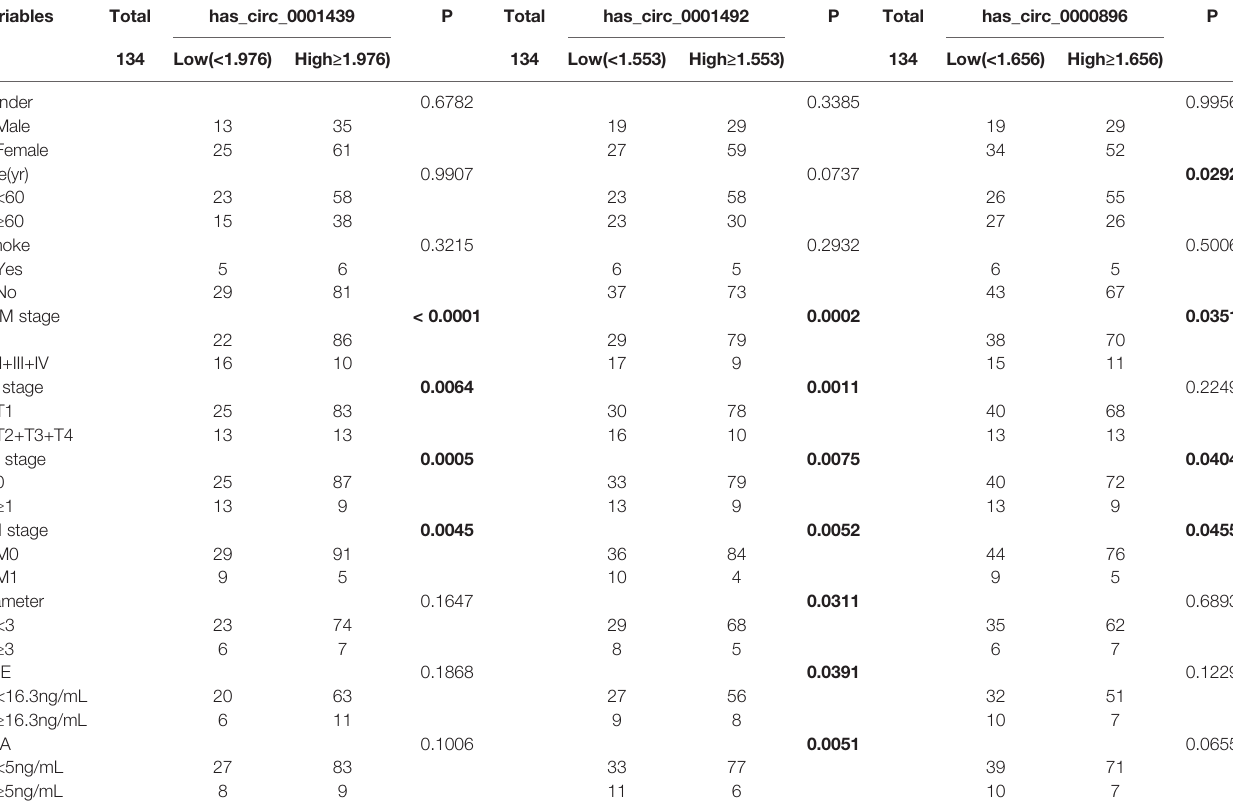
TABLE 3 | The correlation of serum exosomal hsa_circ_0001439, hsa_circ_0001492, and hsa_circ_0000896 expression levels with clinicopathological factors. Variables